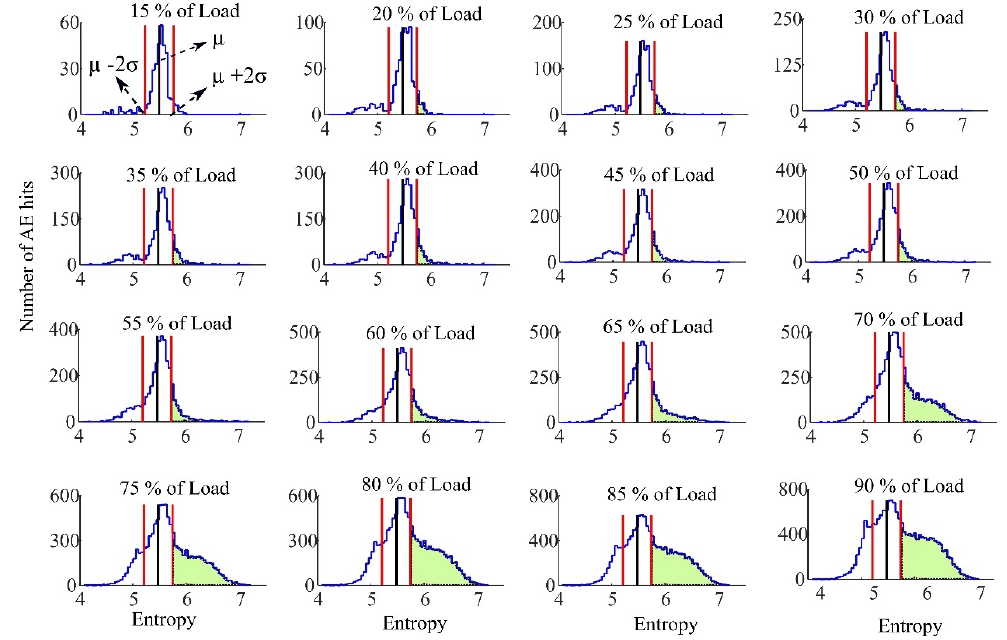
Figure 7. Histogram of the entropy using wavelet transform in different percent of ultimate load.